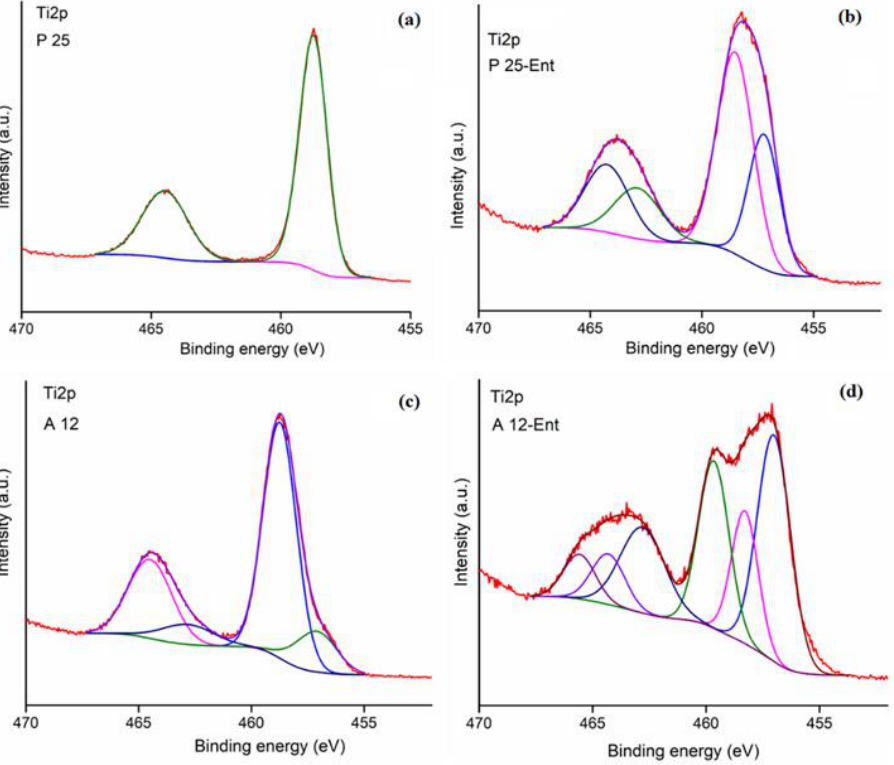
Figure 5. High-resolution XPS spectra of the Ti2p peaks of the P25 ( a , b ) and A12 ( c , d ) samples before ( a , c ) and after ( b , d ) incubation with ent for 24 h .